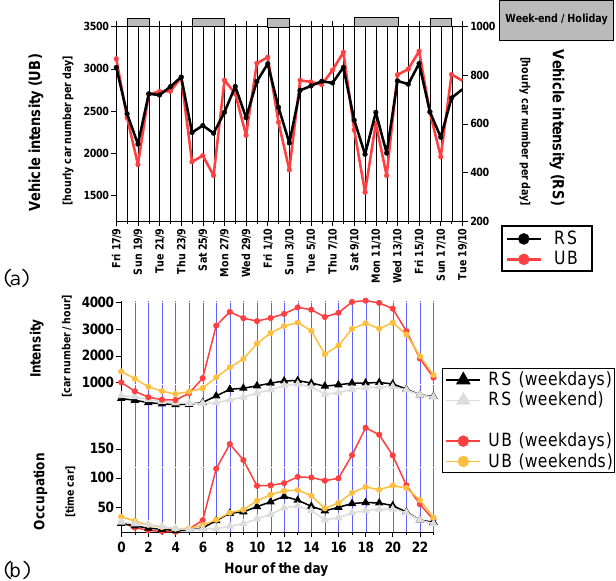
Fig. 2. (a) Average hourly number of vehicles per day at Road Urgell (road RS site) and at Avenida Diagonal (close to the UB) and 2 (b) Diurnal traffic intensity and traffic occupation at the RS site and at Avenida Diagonal